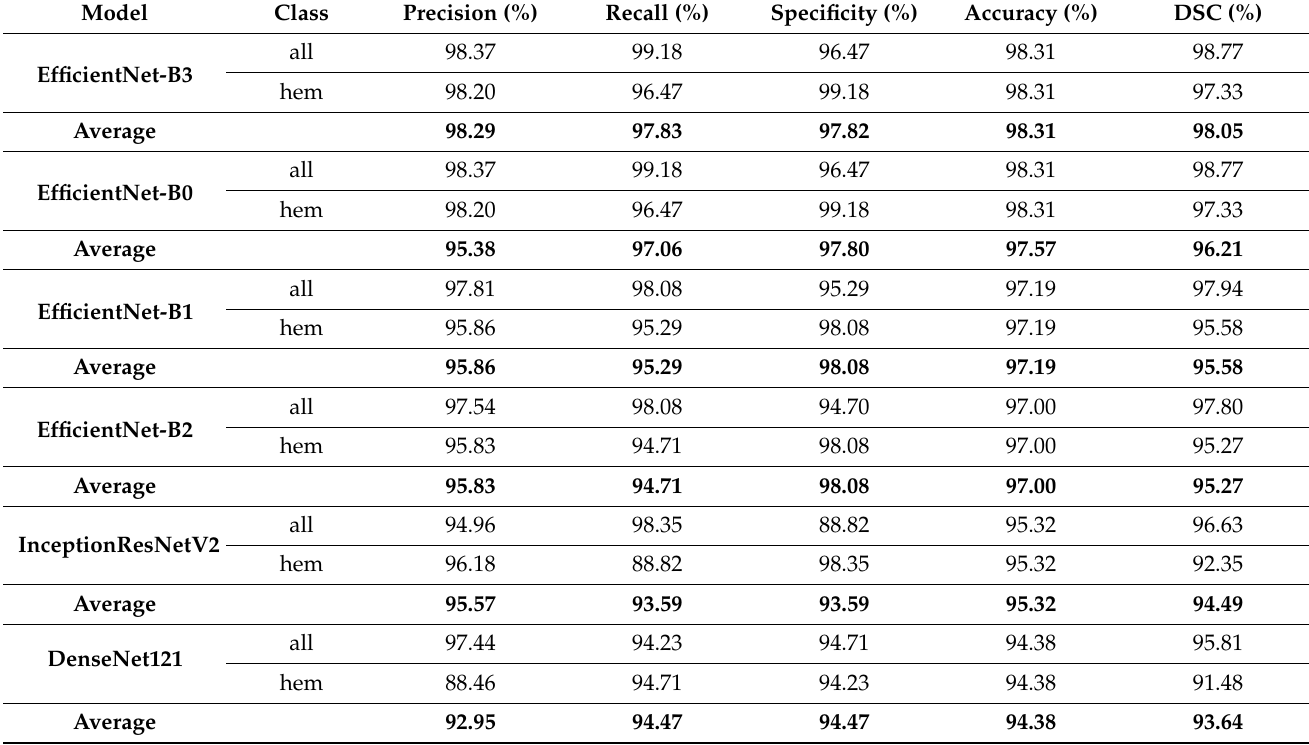
Table 3. Performance of the six CNN models using the proposed dynamic LR.